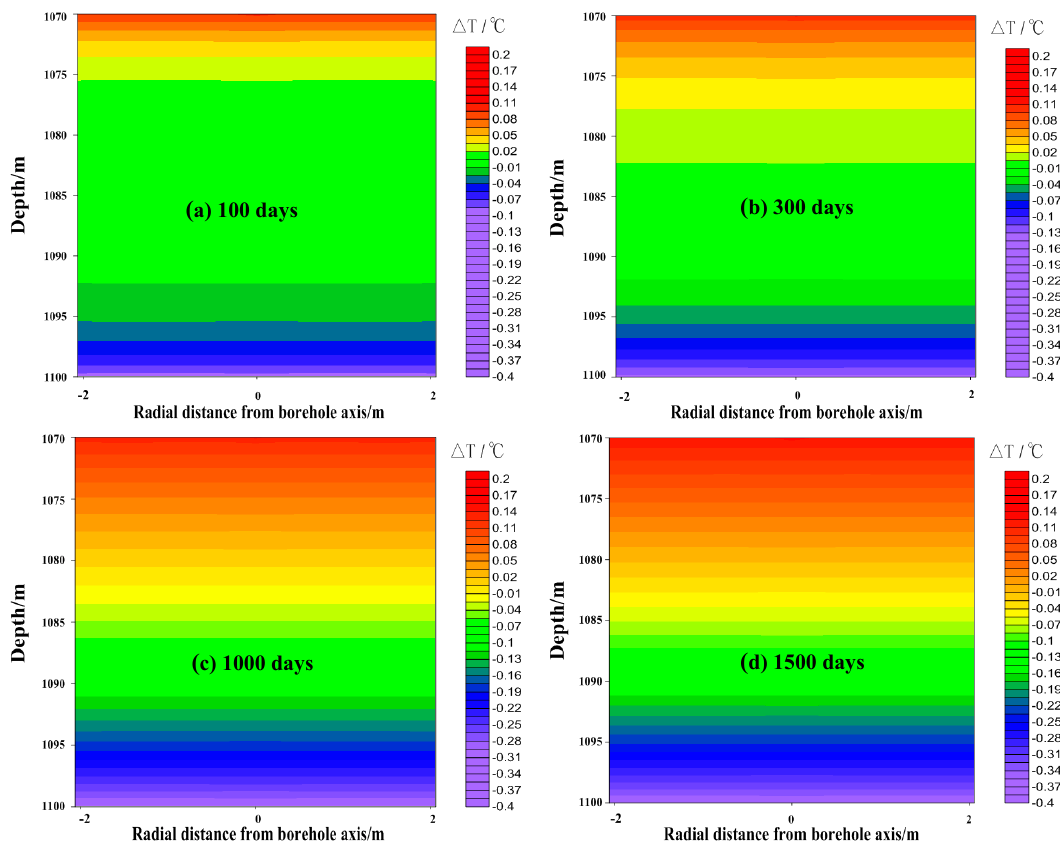
Figure 13. Evolution of the spatial distribution of the temperature variation of the surrounding formation C (1070m ≤ z ≤ 1100 m, − 2.06 m ≤ r ≤ 2.06 m) during the 1500 day period. ( a ), ( b ), ( c ), ( d ) are the temperature distribution of 100, 300, 1000, 1500 days of production time, respectively.